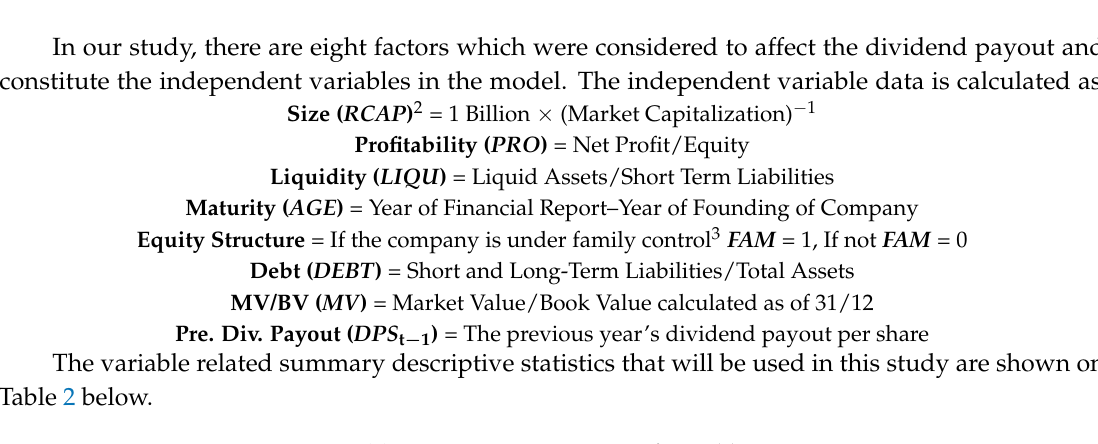
Table 2. Descriptive Statistics of Variables.